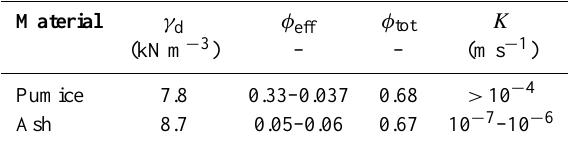
Table 1. Typical characteristics of pyroclastic soils in the Vesuvius area. After Fiorillo and Wilson